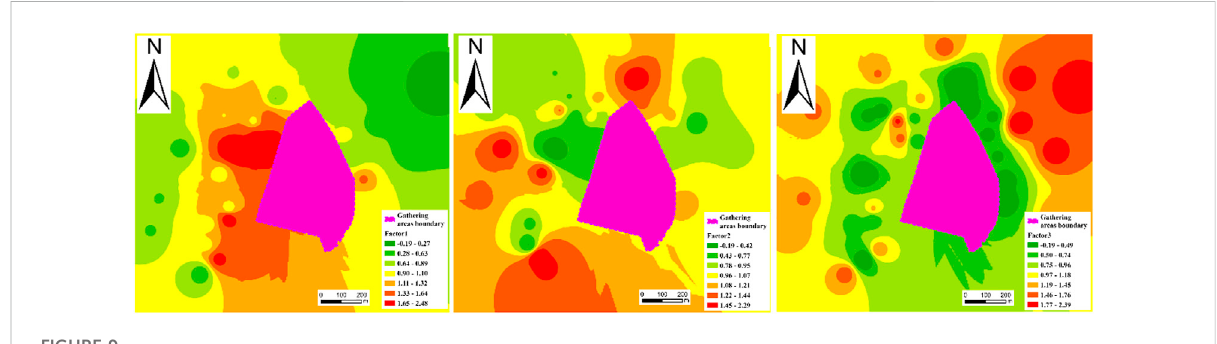
FIGURE 9 Geospatial distribution of three main pollution